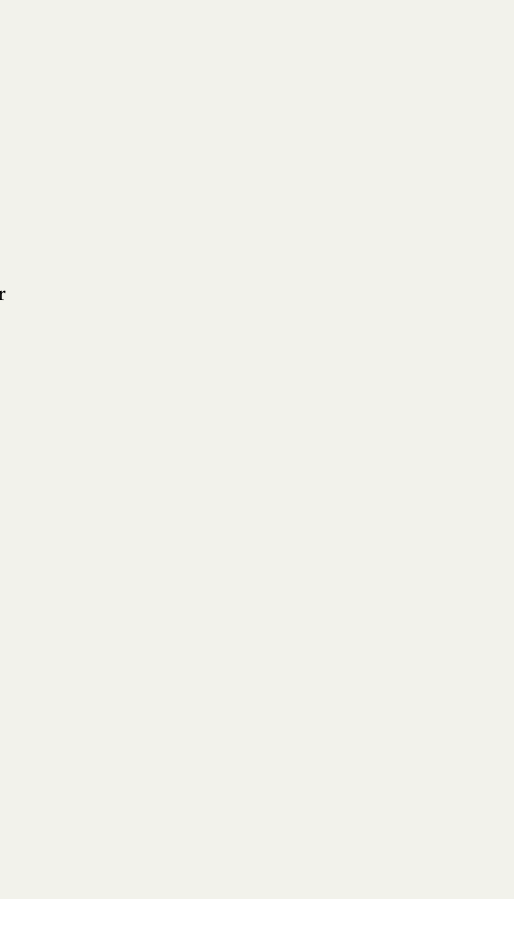
Figure A1. Example illustrating the use of HCLWattsUp API for measuring the dynamic energy